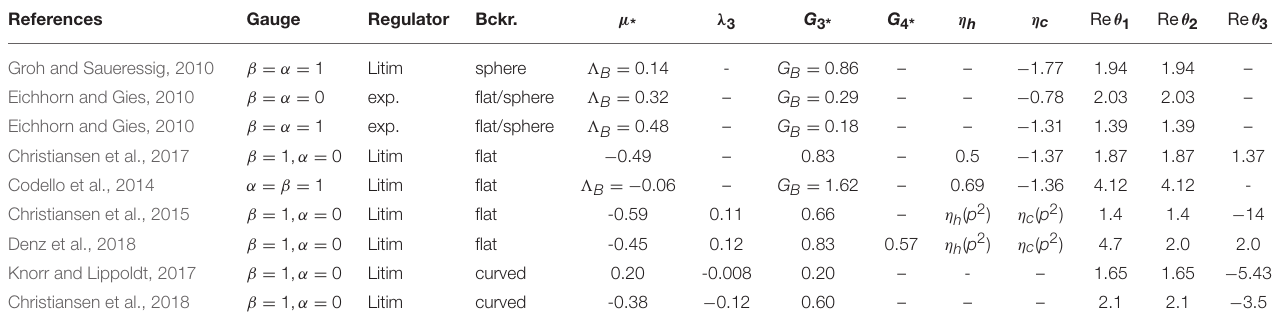
TABLE 4 | Fixed-point results for fluctuation